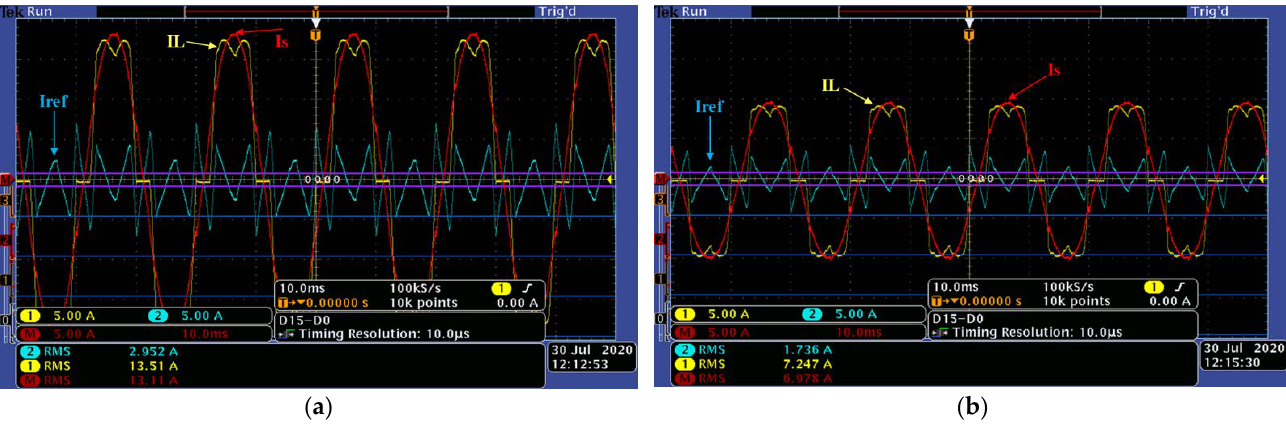
Figure 15. ( a , b ). Experimental results of the load current, distorted identified current, and grid current for two load levels (4 and 2.2 kW).